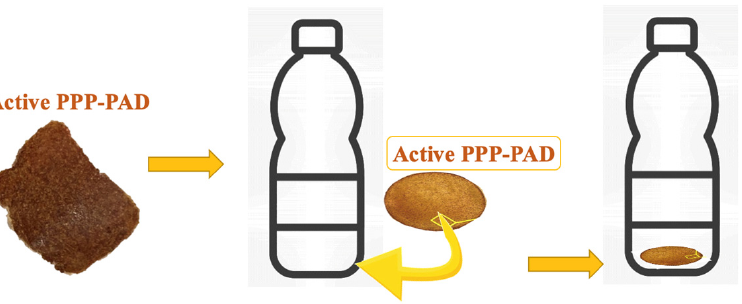
Figure 1. Pad developed in the current study and its future application in a beverage bottle.